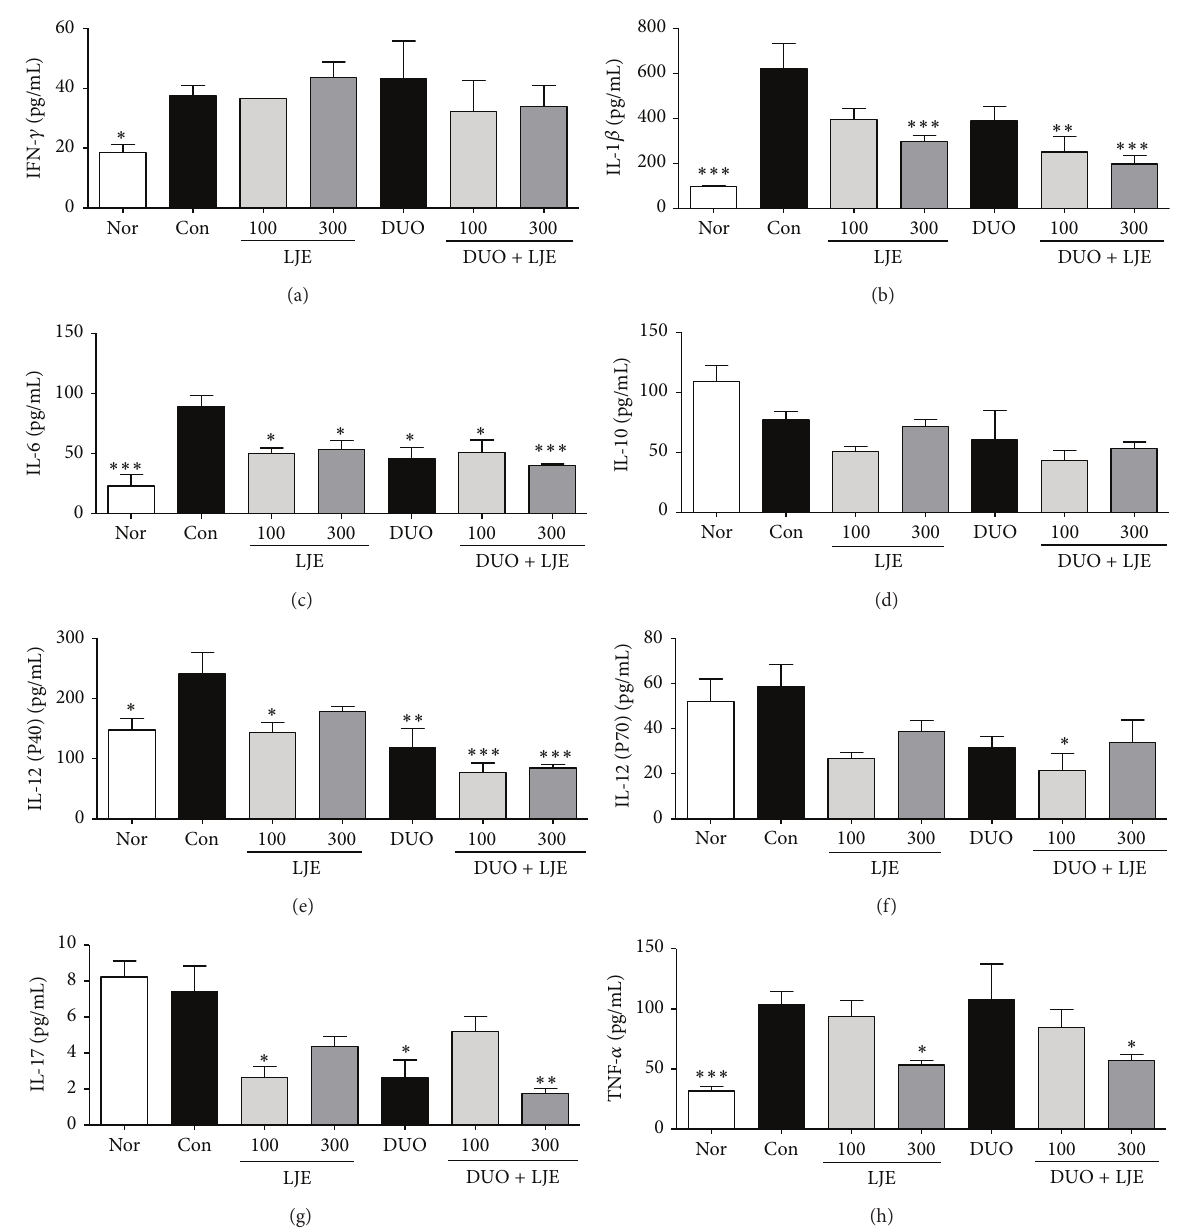
Figure 5: Effects of LJE or DUO on cytokine production in DSS-induced colitis. Data are expressed as mean ± S.E.M ( 𝑛 = 7 ). Nor: normal mice without any treatment, Con: mice provided with only 5% DSS treatment, LJE: the water extract of Laminaria japonica , DUO: Duolac7S, LJE + DUO: cotreatment of LJE and DUO, 100: the dosage of LJE 100mg/kg, and 300: the dosage of LJE 300 mg/kg; ∗ 𝑃 < 0.05 , ∗∗ 𝑃 < 0.01 , and ∗∗∗ 𝑃 < 0.001 versus control group analyzed by one-way ANOVA with Dunnett’s post hoc test. IFN- 𝛾 : interferon- 𝛾 and TNF- 𝛼 : tumor necrosis factor- 𝛼